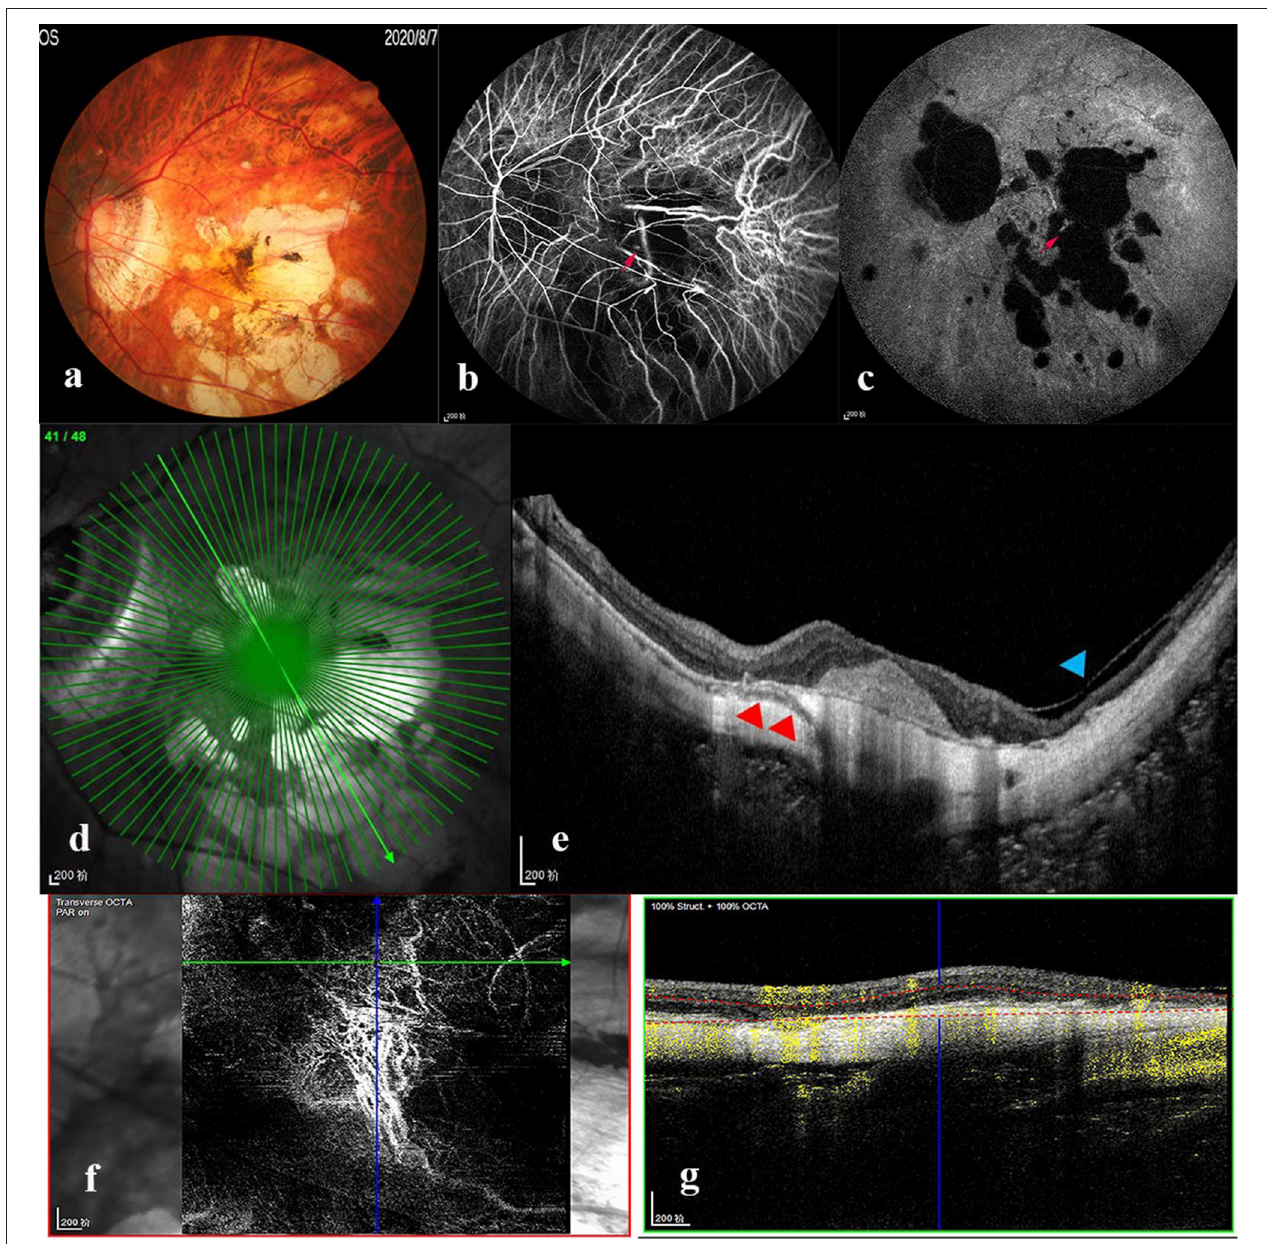
FIGURE 3 | Multimode imaging of a patient who combined the three types of myopic maculopathy. Left eye images of a patient aged 70–75 years old, with an axial length of 29–30mm. (a) Color fundus photograph showed macular atrophy (MAM) and Fuch’s spot (MNM). Fluorescence leakage (red arrow) was seen in the early (b) and late (c) stages of fluorescence angiography. (d,e) OCT image demonstrated foveoschisis (MTM, blue arrowhead) and PSV (red arrowhead) beneath the choroidal neovascularization (CNV). (f,g) OCT-angiography showed CNV (MNM) formation. MAM, myopic atrophic maculopathy; MTM, myopic tractional maculopathy; MNM, myopic neovascular maculopathy; OCT, optical coherence